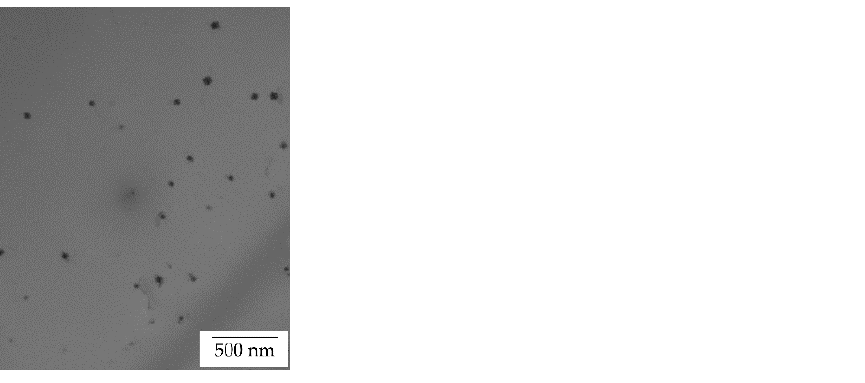
Figure 3. TEM image of the AlYb AC alloy in the initial state — see secondary Al 3 Yb particles.